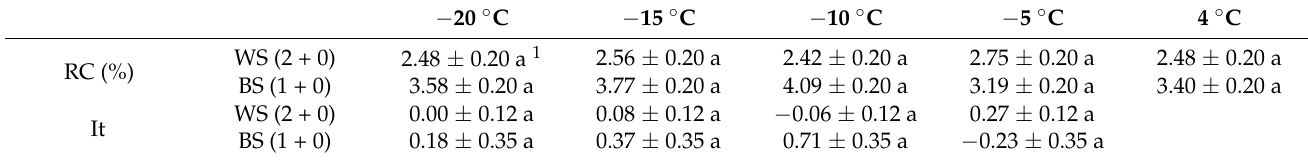
Table 2. Comparison of the adjusted means ( ± standard error) of the relative electrical conductivity (RC) and the index of injury (It) of white spruce (WS) and black spruce (BS) seedlings in response to different freezing temperatures at the end of autumn (30